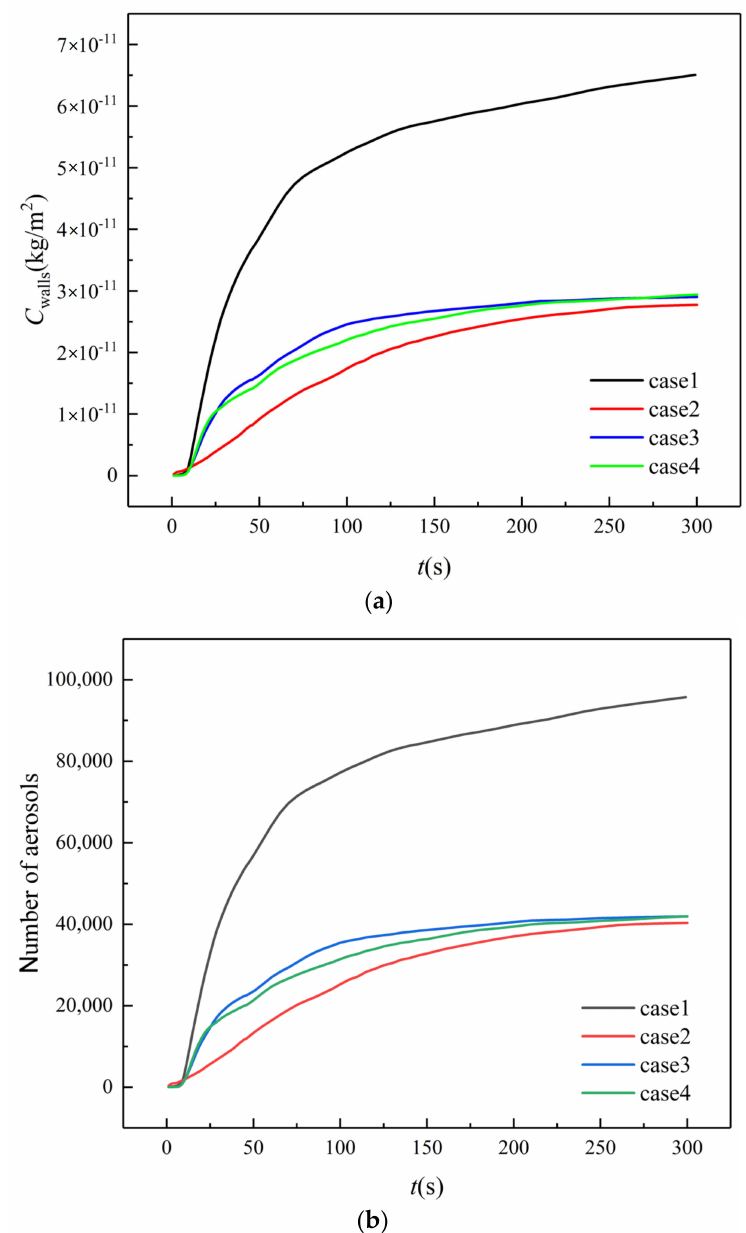
Figure 11. Aerosols on the walls, floor, and ceiling. ( a ) Cumulative concentration; ( b )